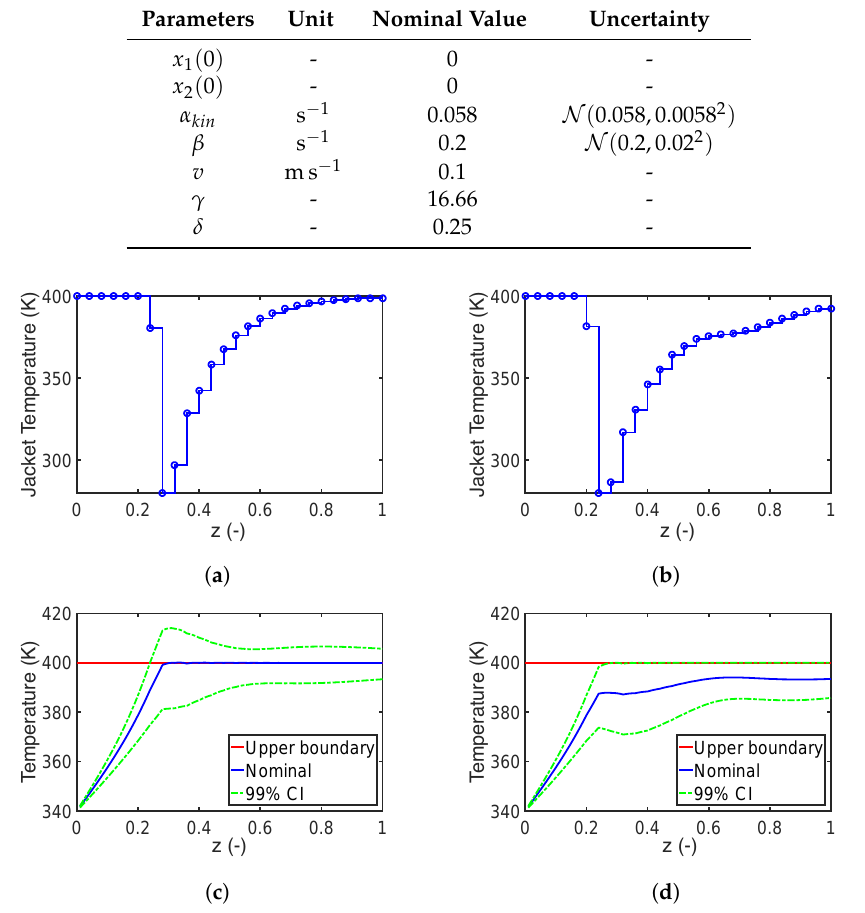
Figure 5. Results for nominal design (left) and robust design (right). ( a , b ) are the optimal profiles of the jacket temperature; ( c , d ) are the evolution of the reactor temperature and the 99% confidence interval (CI). The mean and standard deviation of the conversion of reactant A have values of [0.996, 0.004] and [0.985, 0.010] for the nominal and robust design,